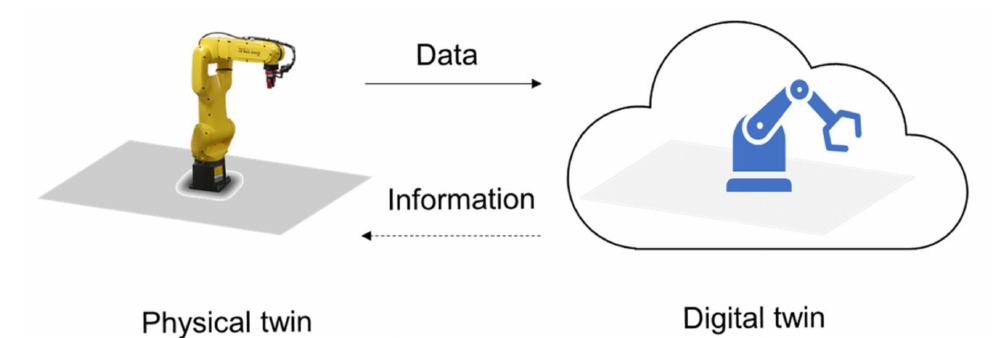
Figure 2. Digital Twin: physical and virtual products. Adopted from [8].